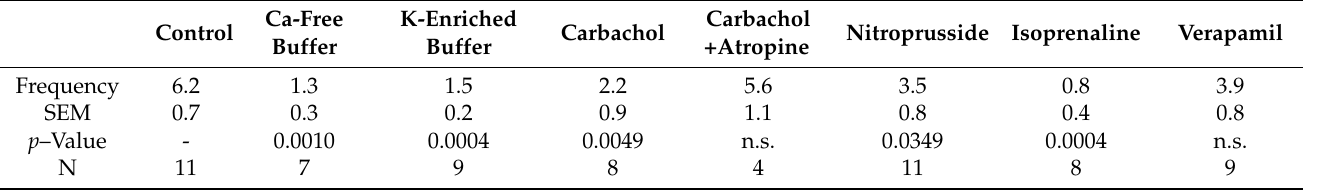
Figure 4. Total isometric force measured as the AUC of cecal circular smooth muscle contraction. The control condition and the reactions to different electrolytes or drugs are shown. The values are